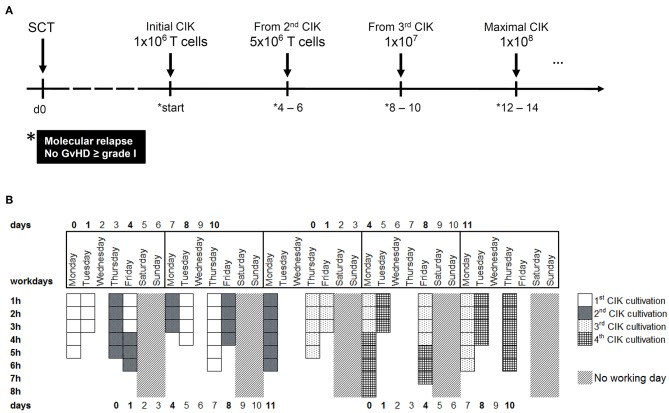
CIK cell generation within the clinical phase I/II study. (A) CIK cells are administered to patients with molecular relapse defined as mixed chimerism ≥1% of recipient (autologous) signals; detectable MRD ≥10−6 or BCR-ABL/ABL ≥10−4. According to ATMP § 4b license, repeated CIK cell applications with escalating doses may be provided to patients suffering from prolonged molecular relapse in intervals of 4–6 weeks under the condition that no GVHD ≥ grade I occurred. (B) Within a time-frame of 5 weeks, four different batches of CIK cells can be manufactured. The working days and the estimated time for tasks like initiation, cytokine stimulation or harvest are shown.